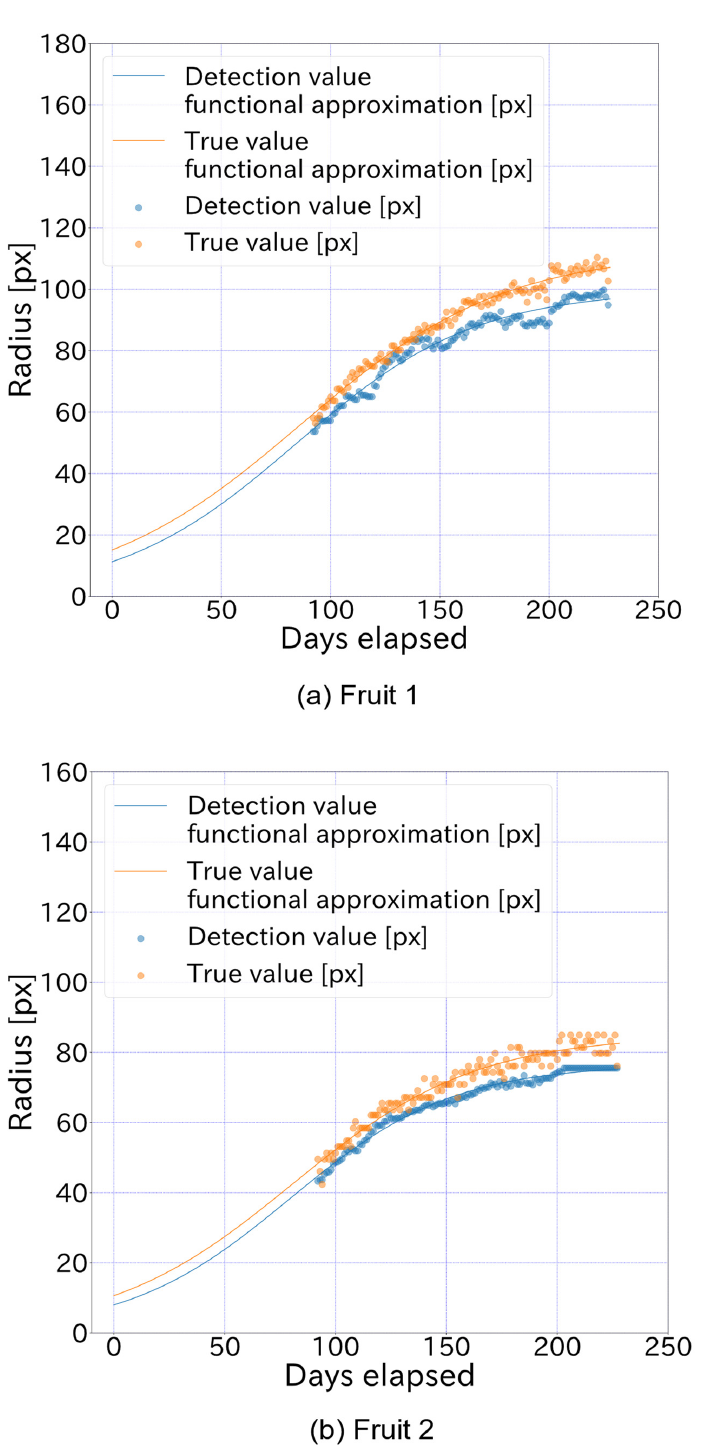
Figure 13. True radius values and detected radius values for each elapsed day. The growth curves derived from the true and detected values up to 227 elapsed days. In Fruit 1, a, b, and c in the functional approximation of Equation (4) are a = 99.71, b = 7.848, and c = − 0.024 for the detection value curve and a = 112.24, b = 6.428, and c = − 0.021 for the true value curve. In Fruit 2, a = 76.61, b = 8.595, and c = − 0.027 for the detection value curve and a = 84.93, b = 7.001, and c = − 0.024 for the true value